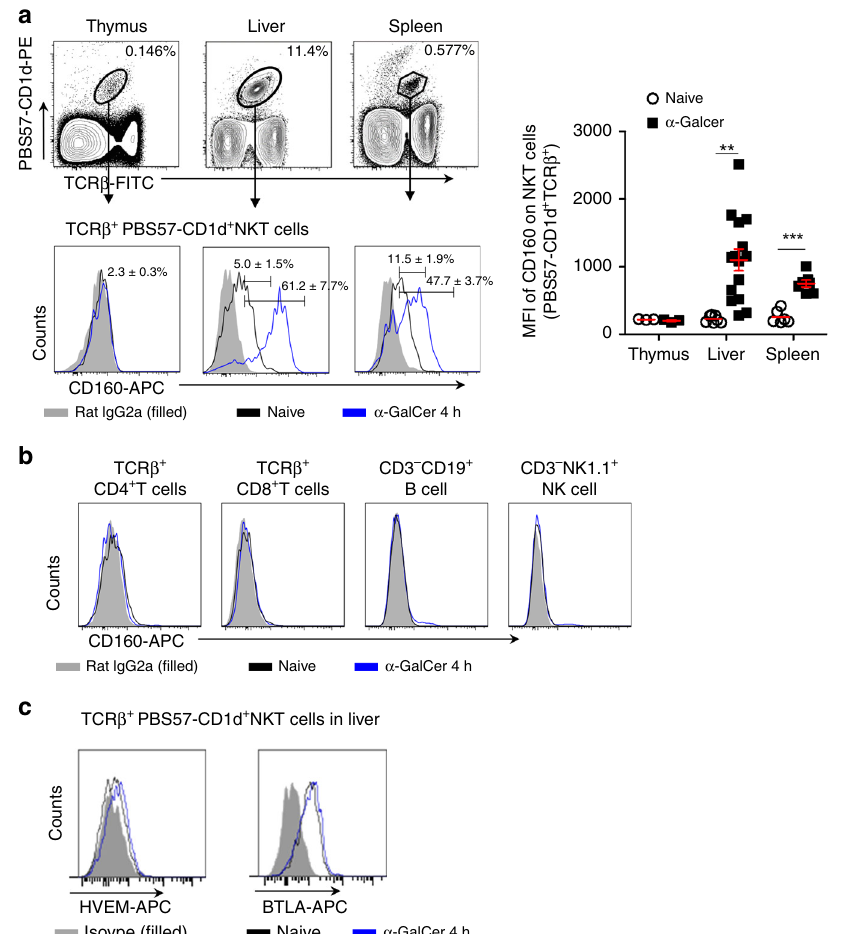
Fig. 1 Upregulation of CD160 on NKT cells after α -GalCer stimulation in vivo. a , b CD160 expression on NKT cells from the thymus, liver, and spleen 4 h before and after α -GalCer challenge in vivo. Lymphocytes were stained with anti-TCR- β , PBS57-CD1d tetramer, and anti-CD160 APC mAb or control IgG. a Representative fl ow cytometry plots of CD160 expression and summary of the frequency of CD160 positivity in gated TCR β + PBS57-CD1d tetramer + from thymus, liver, and spleen NKT cells for 4 h before and after i.p. injection with α -GalCer (2 μ g/mice). The graph represents the mean fl orescence intensity of CD160 expression of NKT cells from the thymus, liver, and spleen ( n = 3 – 15 per group). b Flow cytometry plots of CD160 expression in independent experiments. c Representative fl ow cytometry plots of HVEM or BTLA expression in gated TCR β + PBS57-CD1d tetramer + NKT cells from